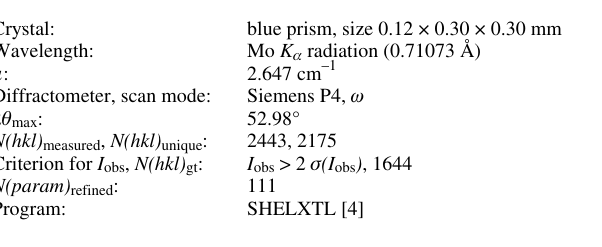
Table 1. Data collection and